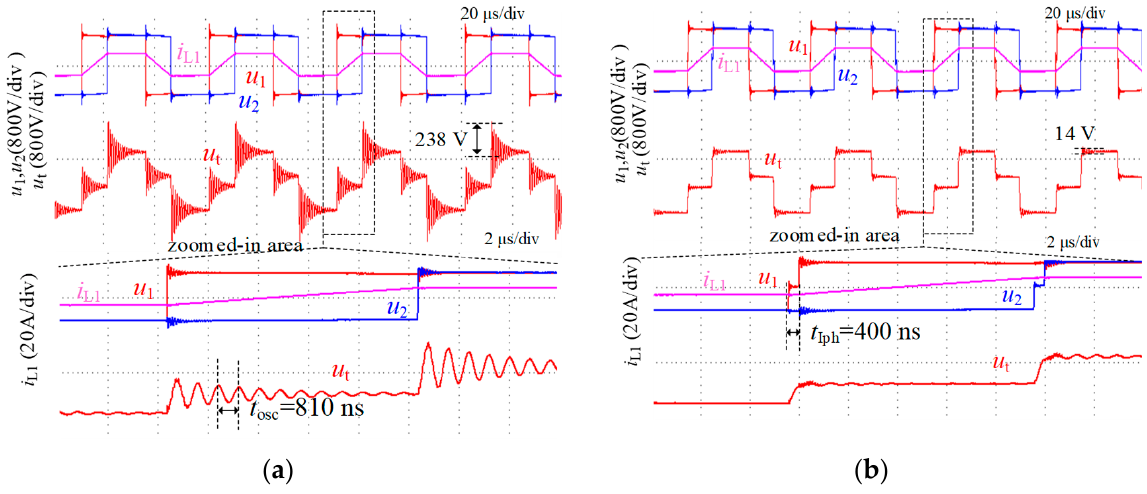
Figure 12. Waveforms of the DAB converter with forward power flow ( D = 0.4): ( a ) no suppression; ( b ) with the SHE PS method.